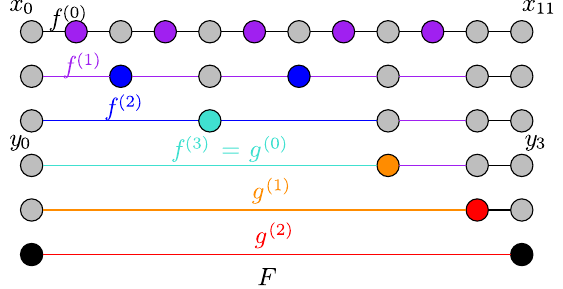
FIG. 2. Here, we find F for w ¼ 11 . We represent the variables x with circles and the functions f or g with lines. Each line with i the same color corresponds to the same function. The variables that are not in gray are eliminated at the next step. At the zeroth iteration, there are 10 functions f ð 0 Þ depending on 11